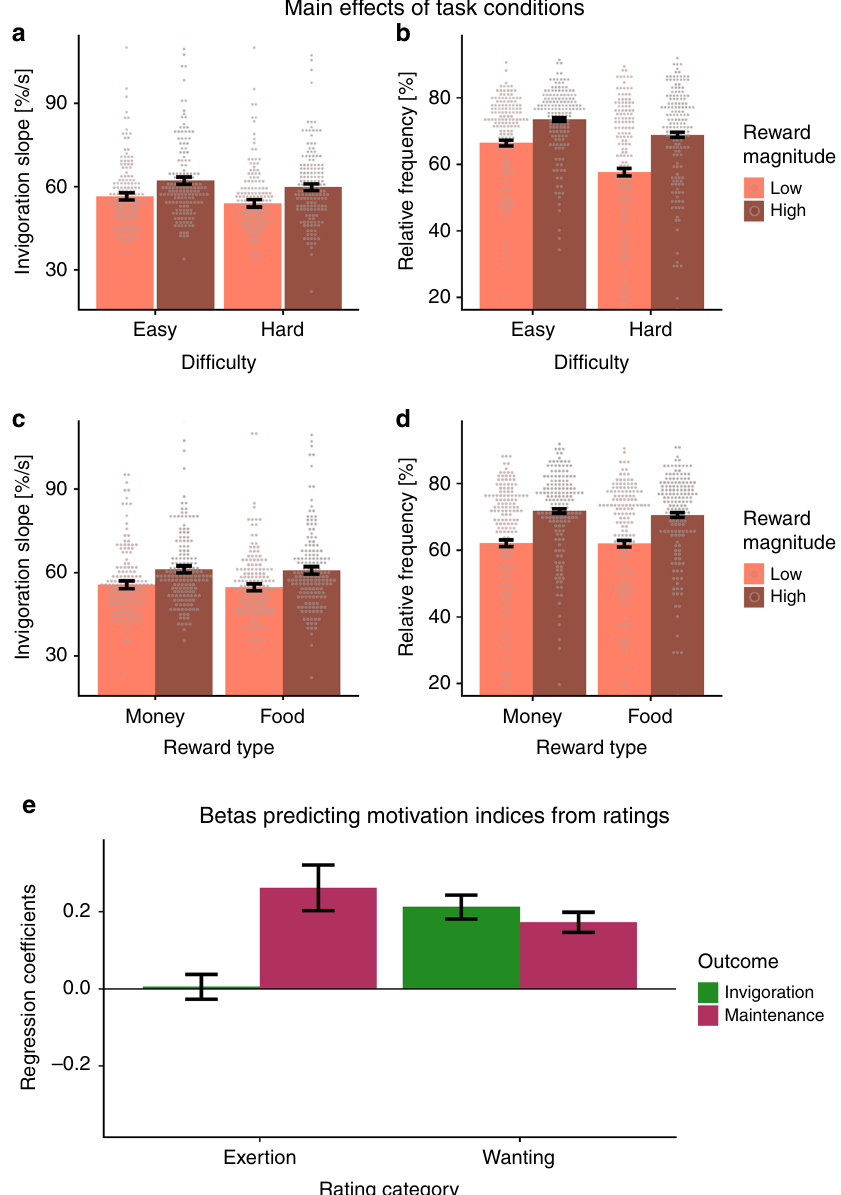
Fig. 2 Invigoration is associated with reward magnitude and wanting, but not with exertion. a Participants were quicker to invigorate if more reward was at stake, p < 0.001, and slower if dif fi culty was high, p = 0.002. b Participants exerted more effort when more reward was at stake, p < 0.001, and less when it became more dif fi cult to obtain it, p < 0.001. Moreover, they worked more for dif fi cult reward when the magnitude was high, p < 0.001. c Food and monetary rewards elicited comparable invigoration, p = 0.45. d Food and monetary rewards elicited similar investment of effort, p = 0.45. e Effort maintenance was related to both ratings of exertion and wanting, p s < 0.001, but invigoration was only related to wanting, p < 0.001, not exertion, p = 0.88. n = 7776 trials of 81 participants; dots depict condition means per participant, bars depict data as sample mean values; error bars depict 95% con fi dence intervals at the trial level ( a – d ) or of fi tted coef fi cients at the participant level ( e ). %/s = button press rate in % of maximum per s. Statistics refer to two- sided t-contrasts of the mixed-effects models reported in Supplementary Tables 1, 2, approximate degrees of freedom = 78, no adjustments for multiple comparisons. Source data are provided as a Source Data fi